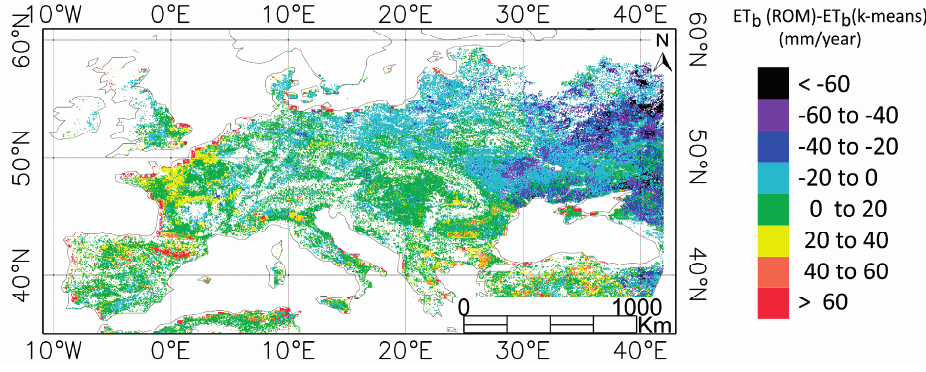
Figure 7. Difference between yearly ET